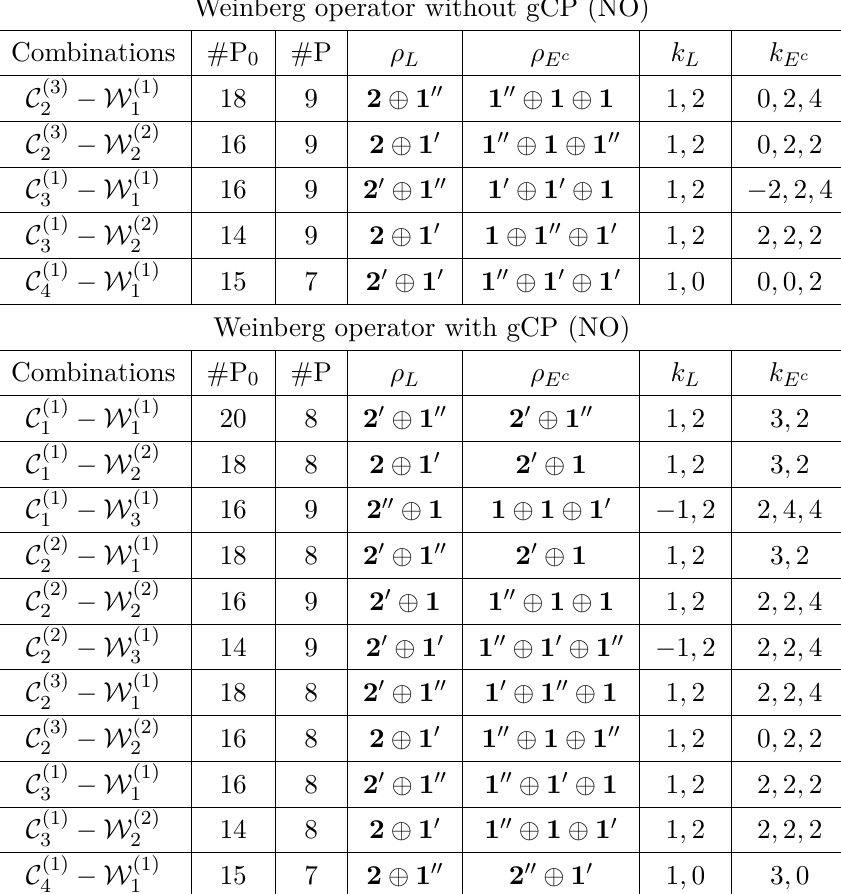
Table 18. Representative models of the viable patterns of texture zero in ( M E , M ν ) that can accommodate the experimental data at 3 σ level for NO neutrino mass spectrum. Here neutrinos are Majorana particles and neutrino masses are assumed to be described by the Weinberg operator. Models with and without gCP are considered. The same convention as table 14 is